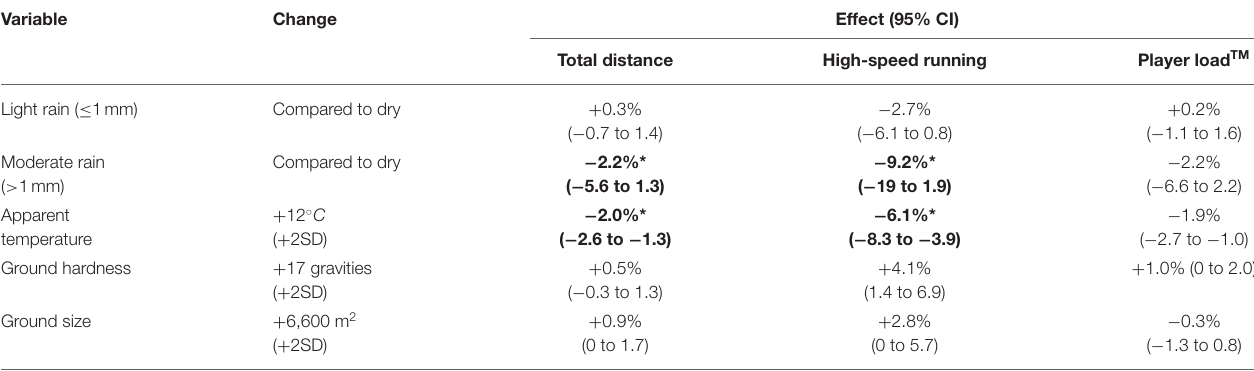
TABLE 7 | The effects of weather and ground